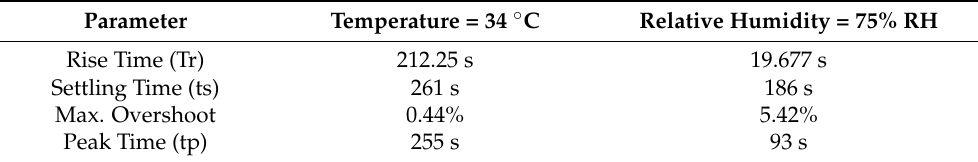
Table 5. Characteristics of the system response to set point temperature 34 ◦ C and humidity